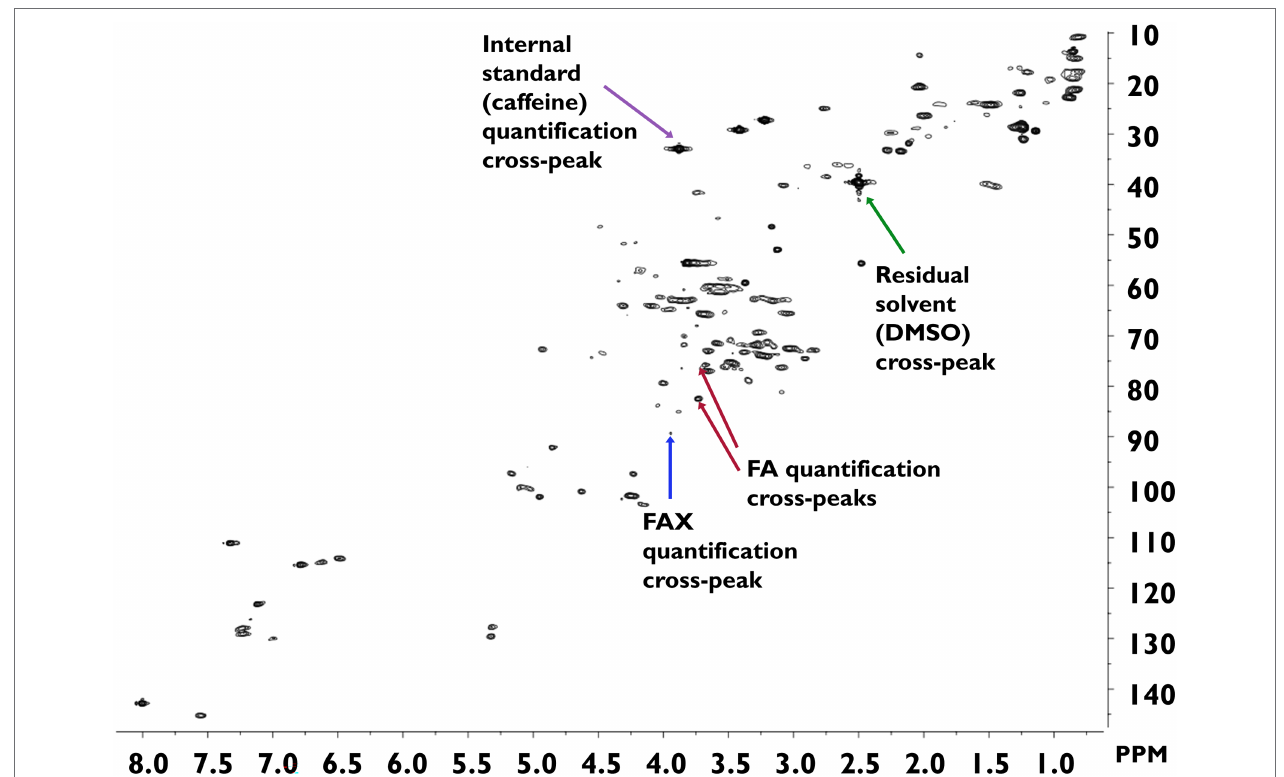
FIGURE 3 | HSQC-NMR spectrum of wild rice hydrolysate. Spectra were measured in DMSO- d 6 and calibrated against the residual DMSO signal ( 1 H = 2.50 ppm; 13 C = 39.52 ppm). DMSO, dimethyl sulfoxide; FA, 5- O - trans -feruloyl- l -arabinofuranose; FAX, β - d -xylopyranosyl-(1 → 2)-5- O - trans -feruloyl- l -arabinofuranose; FAXG, α - l -galactopyranosyl-(1 → 2)- β - d -xylopyranosyl-(1 → 2)-5- O - trans -feruloyl- l -arabinofuranose; HSQC, heteronuclear single quantum coherence spectroscopy; NMR, nuclear magnetic resonance.